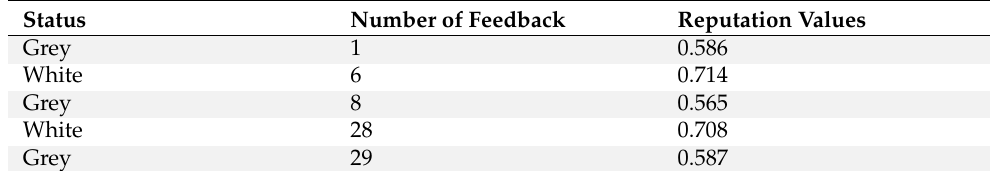
Table 4. Reputation Values representing variation in SP2